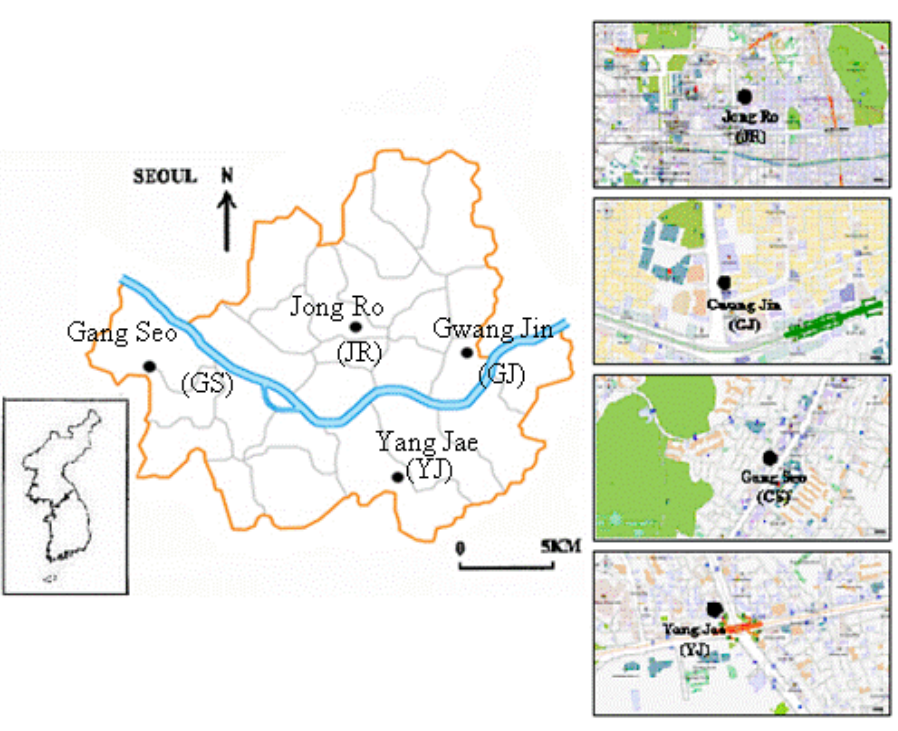
FIGURE 1. Geographical location of four study sites: Jong Ro (JR), Gwang Jin (GJ), Gang Seo (GS), and Yang Jae (YJ) in Seoul,